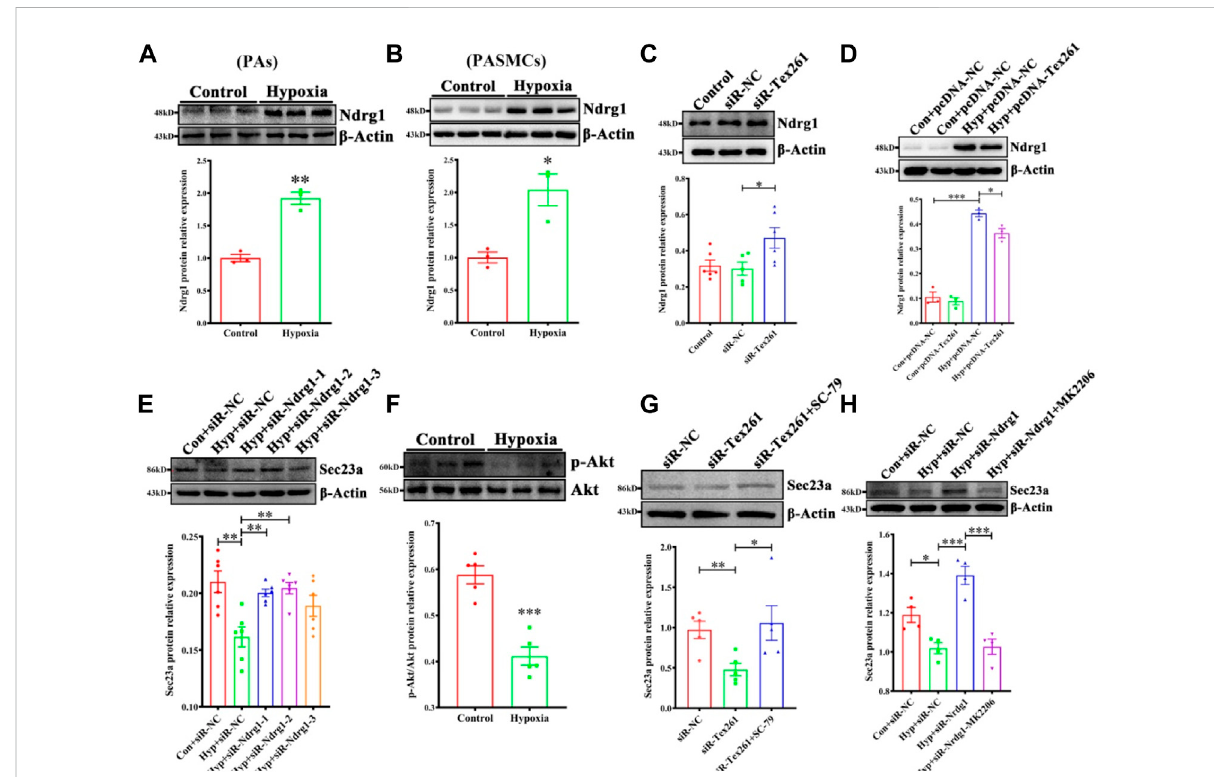
FIGURE 5 Tex261 regulates Sec23 through Ndrg1 mediated Akt pathways. (A,B) Ndrg1 expression was detected in hypoxic PAs and PASMCs ( n = 3). (C) After Tex261 silencing, Ndrg1 expression was detected in PASMCs by Western blots ( n = 6). (D) After Tex261 overexpression, Ndrg1 was measured ( n =4). (E) AfterNdrg1knockdown,Sec23expressionwasexamined( n =6). (F) TheAktpathwaywasdetectedafterPASMCswereexposedtohypoxia ( n = 5). (G) Cells were pretreated with the Akt agonist SC-79 before Tex261 knockdown, and Sec23 was then measured ( n = 5). (H) Cells were pretreated with the Akt blocker MK2206 before silencing Ndrg1, and Sec23 was then tested ( n = 4). Data are presented as the mean ± SEM. * p < 0.05and** p < 0.01vs.control.* p < 0.05and*** p < 0.001vs.con+pcDNA3.1-NC.* p < 0.05, ** p < 0.01and*** p < 0.001vs.thecontrol+siR-NCor hypoxia +